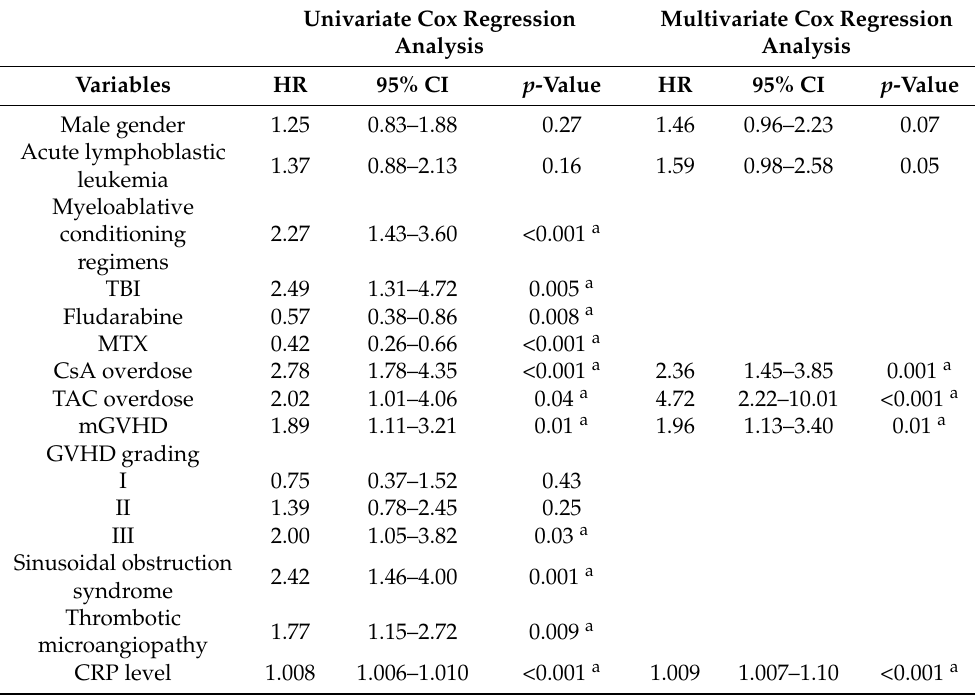
Table 2. Univariate and multivariate Cox regression analysis for evaluation of risk factors associated with AKI in the first 100 days after